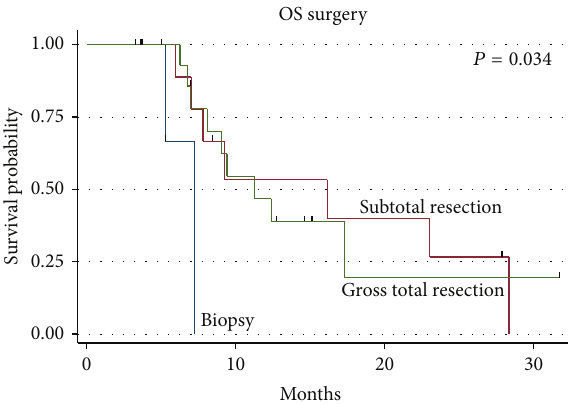
Figure 3: Overall survival by extent of surgical debulking.